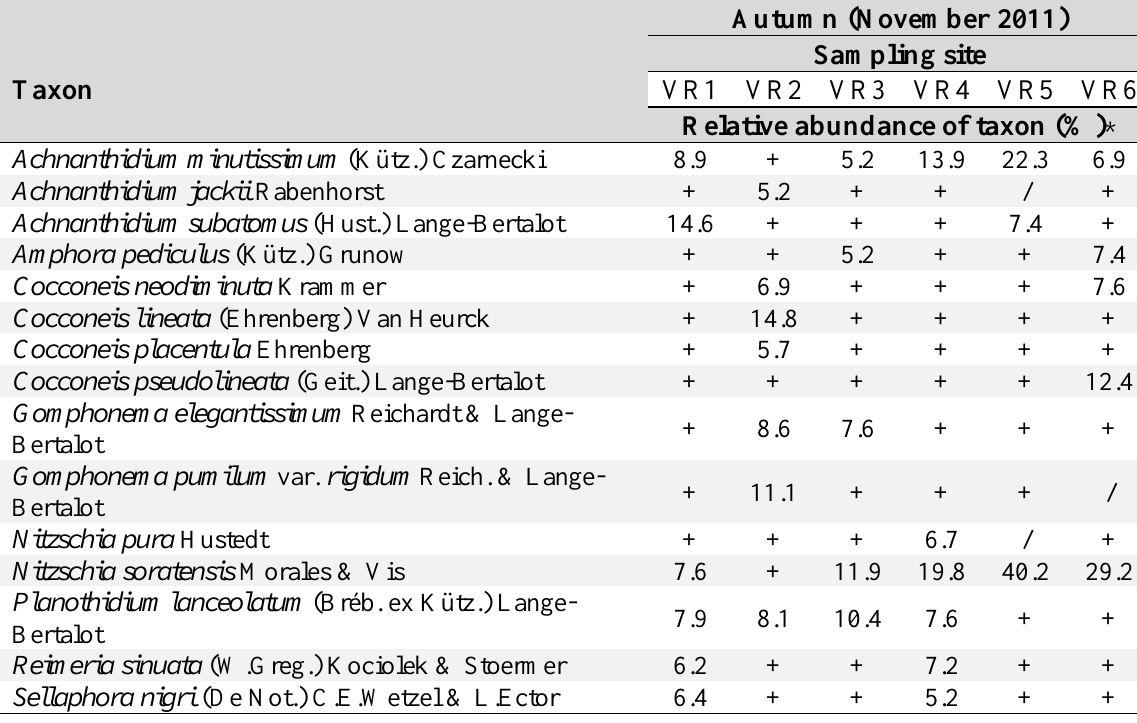
Table 3. Relative abundance of diatom taxa (%) present in the epilithic diatom community in the Vrla River during the autumn period (November 2011).